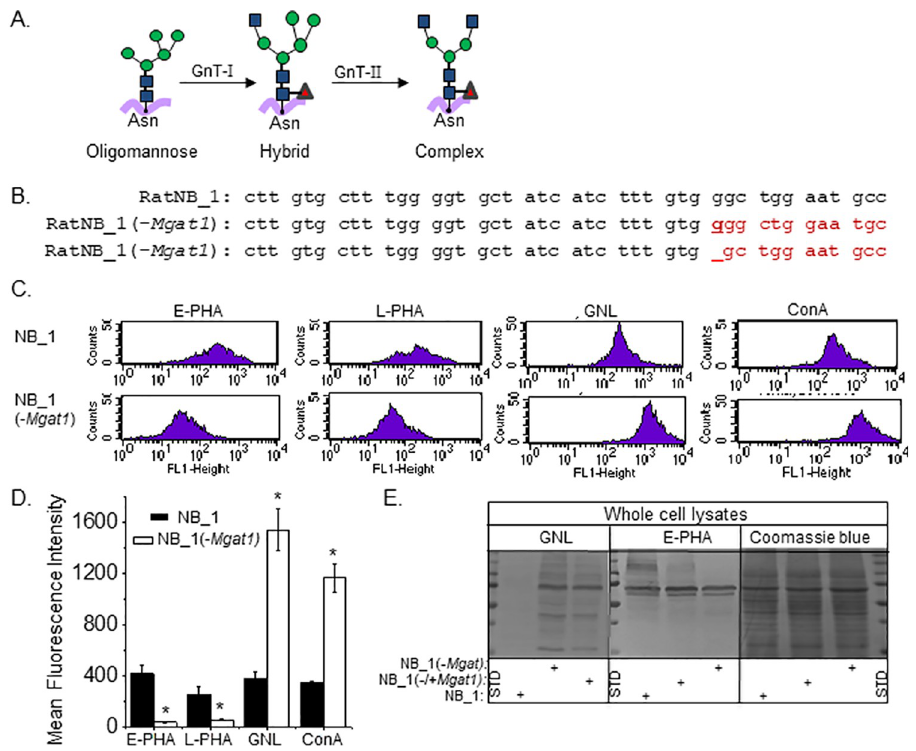
Fig 1. Characterization of a neuroblastoma cell line with knockout of GnT-I. (A) The simplest N-glycan is oligomannose which gives rise to more mature N-glycans, hybrid and complex. GnT-I converts oligomannose to hybrid, and subsequently GnT-II converts hybrid to complex. (B) The coding sequence of rat Mgat1 from 25 to 66 was compared to that isolated from a newly created NB_1(- Mgat1 ) cell line. Two frameshift mutations were identified, including an inserted g nucleotide and a deletion of a g nucleotide as indicated in bold red font and dash line, respectively. Further the next in-frame start codon does not occur until residue 251 (C) Typical flow cytometry plots of NB_1 (top panels), and NB_1(- Mgat1 ) (bottom panels) cell lines interacting with fluorescently labelled lectins. (D) Mean fluorescence intensity of E-PHA ( n = 5), L-PHA ( n = 5), GNL ( n = 5) and ConA ( n � 2) bound to NB_1 and NB_1 (- Mgat1 ) cells. Graph denotes mean ± SEM and were compared by student’s t-test ( � p < 0.01). (E) Lectin blots and a coomassie blue stained gel of proteins from whole cell lysates of NB_1 and NB_1(- Mgat1 ) cell lines. Vertical dotted and solid lines denote gel lane dividers and a different gel, respectively. Molecular weight standards (STD) in kDa: 250; 150; 100; 75; 50; and 37 from top to bottom.